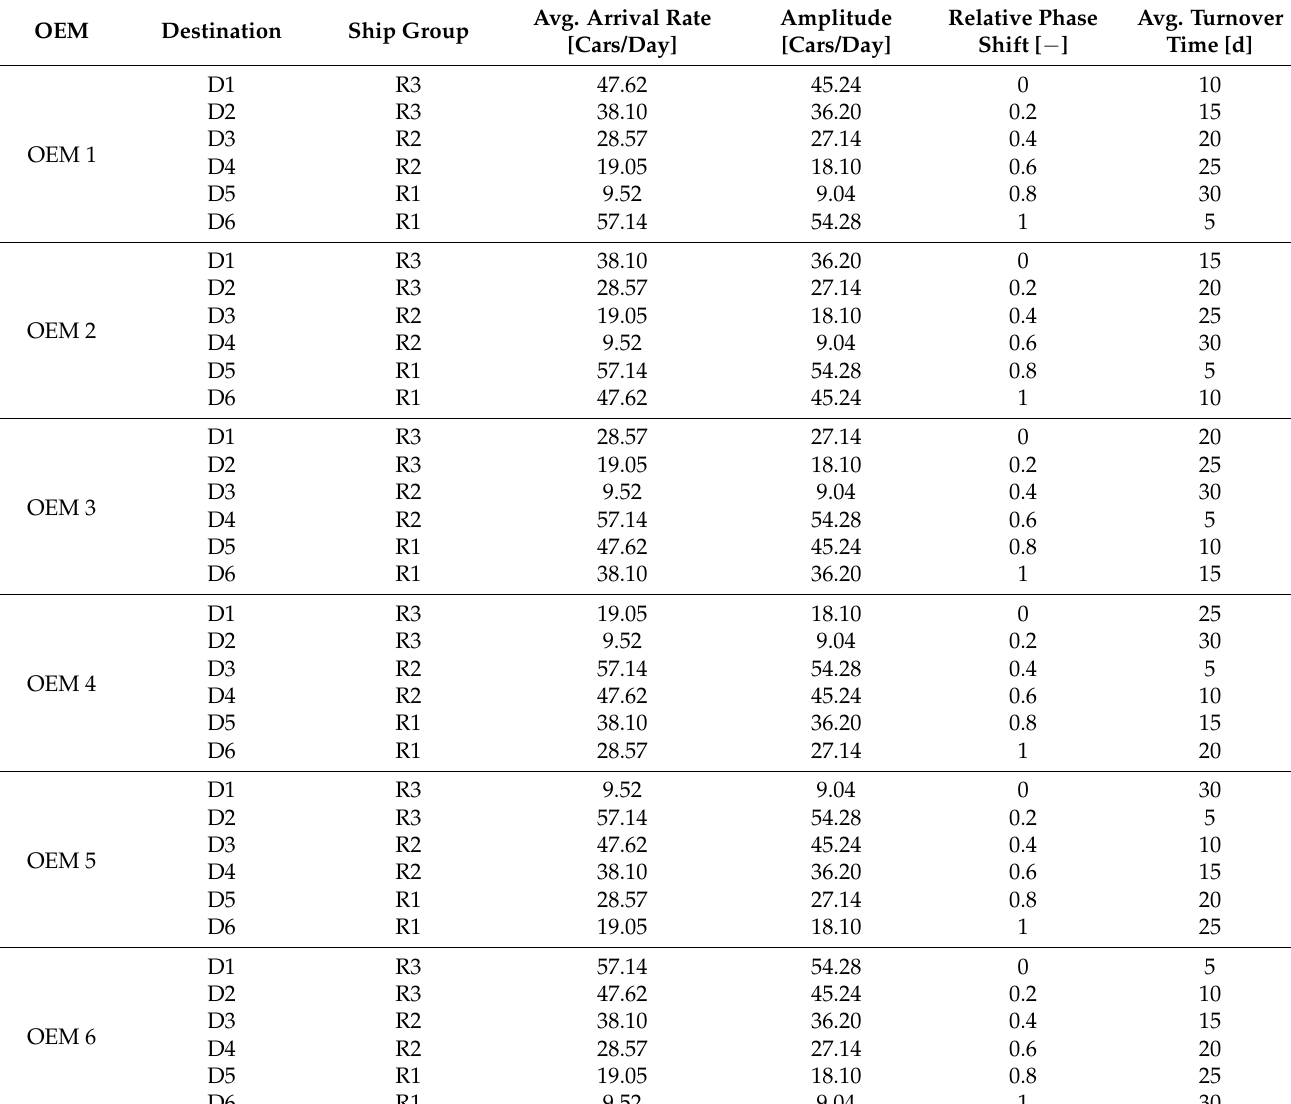
Table 1. Arrival parameters in the generic model.